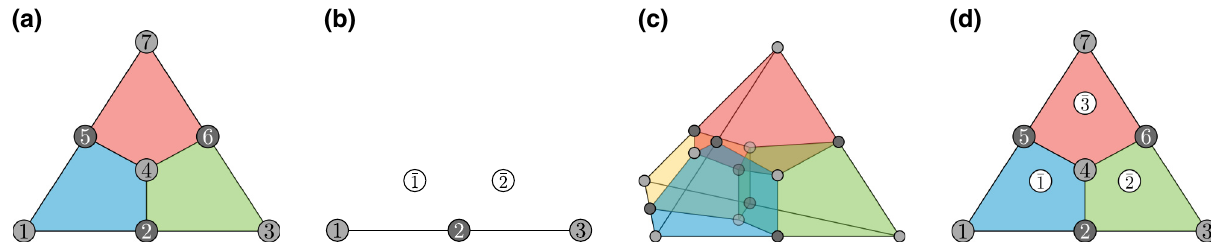
¯ ¯ 1 and 2. (cid:5) . To implement S , we apply S ± 1 to the light and dark , X 2 X 3 X ¯ , Z 1 Z 2 Z ¯ , Z 2 Z 3 Z ¯ 1 2 2 1 . (c) The [[15,1,3]] Reed-Muller code. Qubits are on vertices; X - and Z -type 1 ¯ 2 ¯ ¯ ¯ 1, 2 and 3. The stabilizer group of the [[10,1,2]] , Z 1 Z 2 Z 4 Z 5 , Z 4 Z 5 Z ¯ and the analogous operators for the red and green faces. To implement T , we 1 2